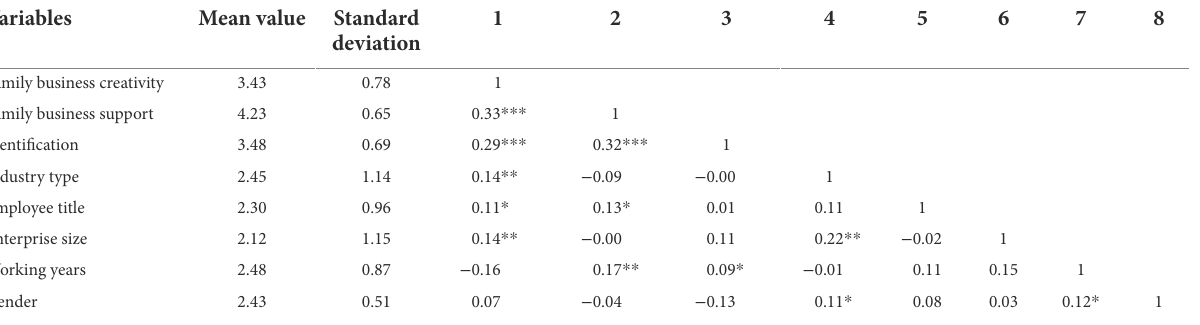
TABLE 3 Related analysis